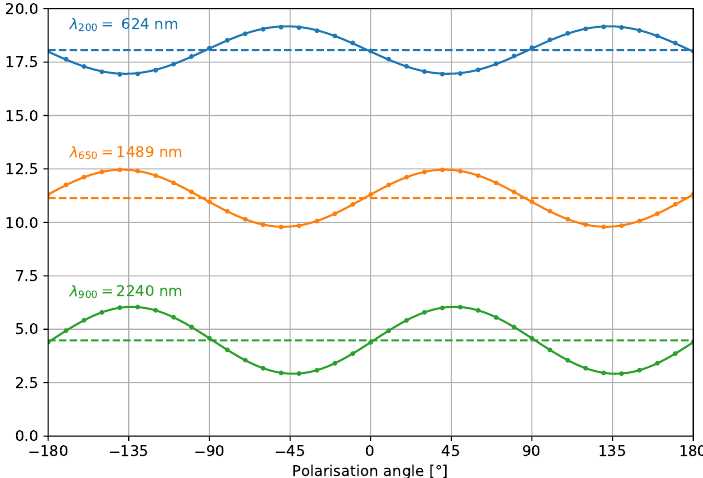
Figure 9. Spectroradiometer response of three channels to linear-polarized light as a function of the polarization angle with respect to the spectroradiometer slit orientation. The polarization sensitive response follows Malus’s law, as shown by the fits with Equation